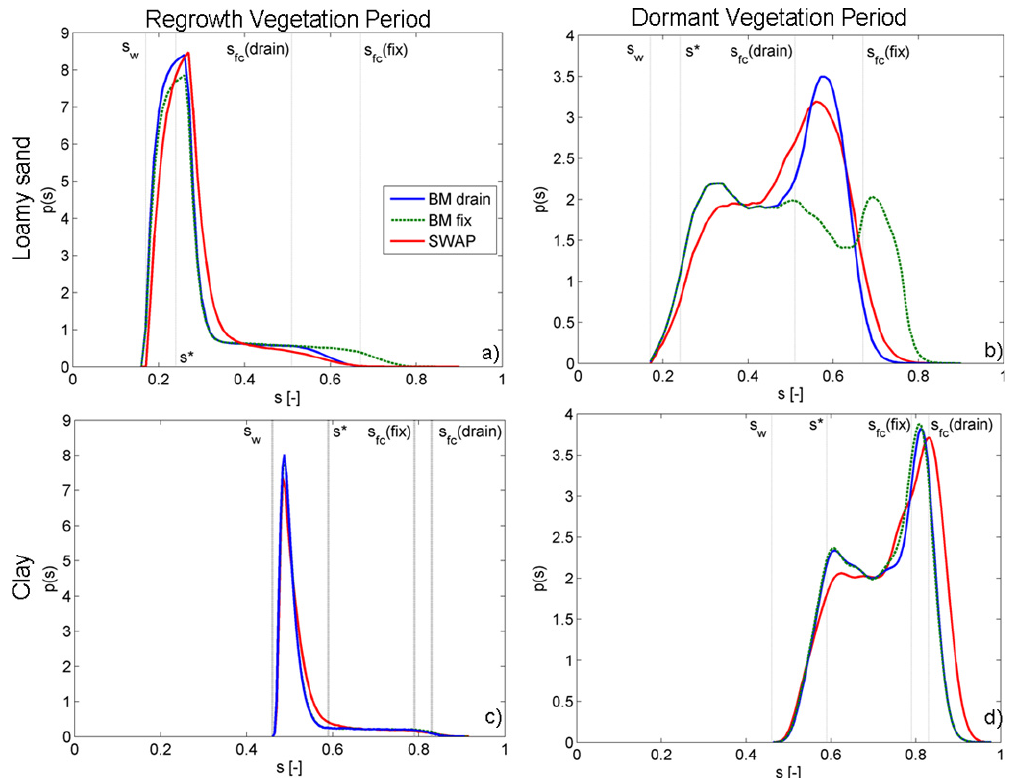
Fig. 8. Probability density functions of relative soil moisture content, s , for the loamy-sand soil (5a and 5b) and for the clay soil (5c and 5d). The plots on the left-hand-side refer to the RVP season, whereas the plots of the right-hand side refer to the DVP season. Red solid lines are the SWAP model results used as a reference; blue solid lines refer to BM when field capacity is parameterized with the drain -method; green dotted lines refer to BM when field capacity is parameterized with the fix